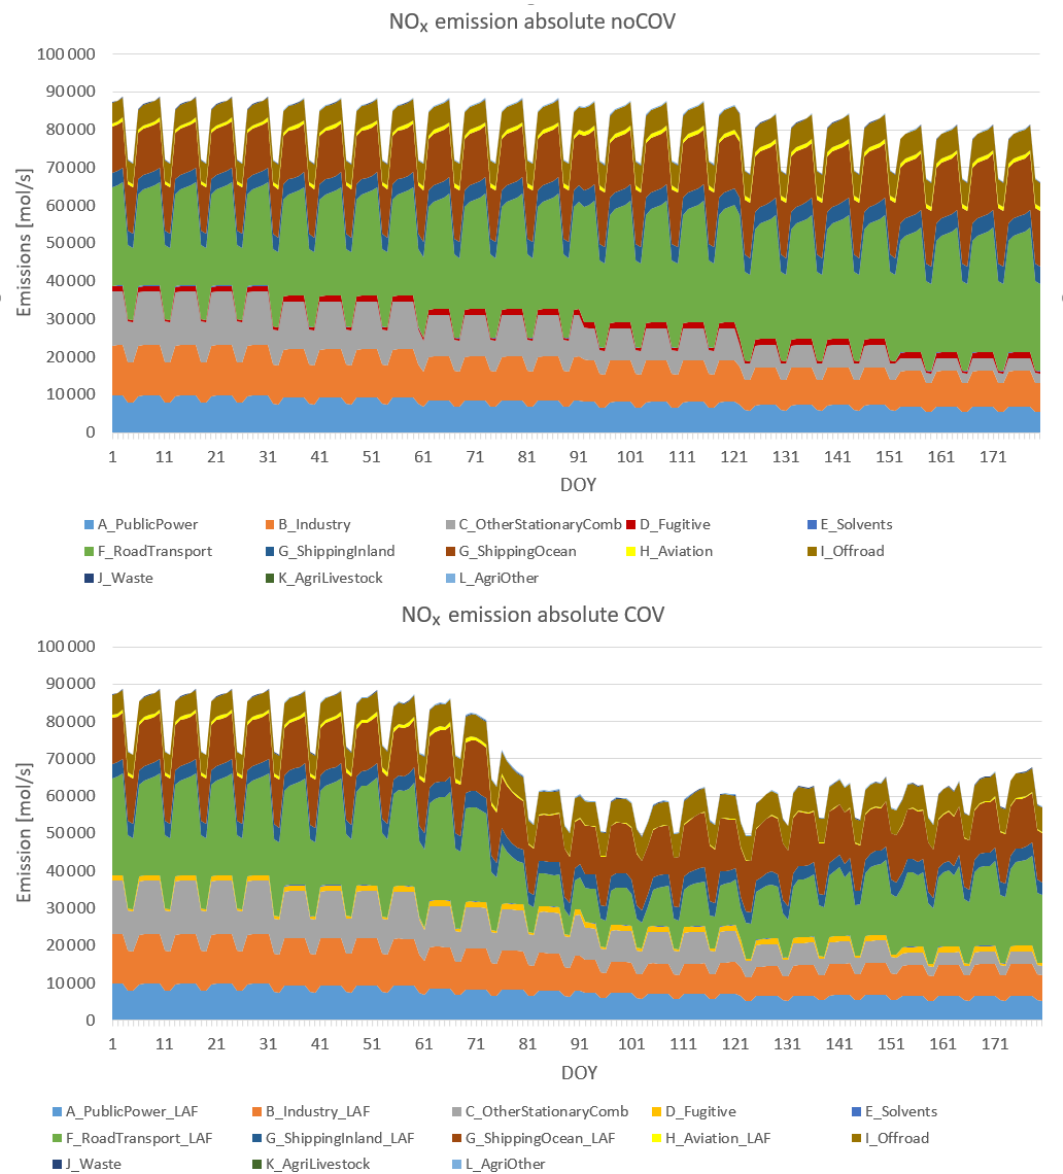
Figure 5. Daily average values for sector separated NO x emissions summarized over the entire central European model domain for the noCOV and the COV case (with